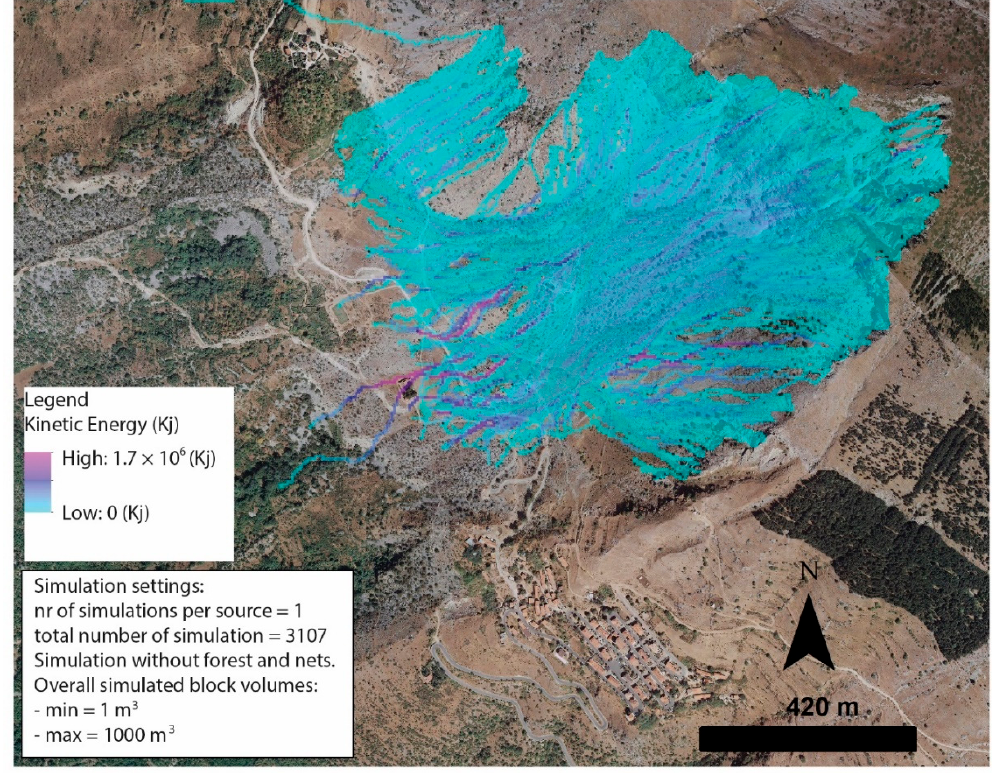
Figure 19. Map of the kinetic energy extracted from the simulation shown in Figure 18B.